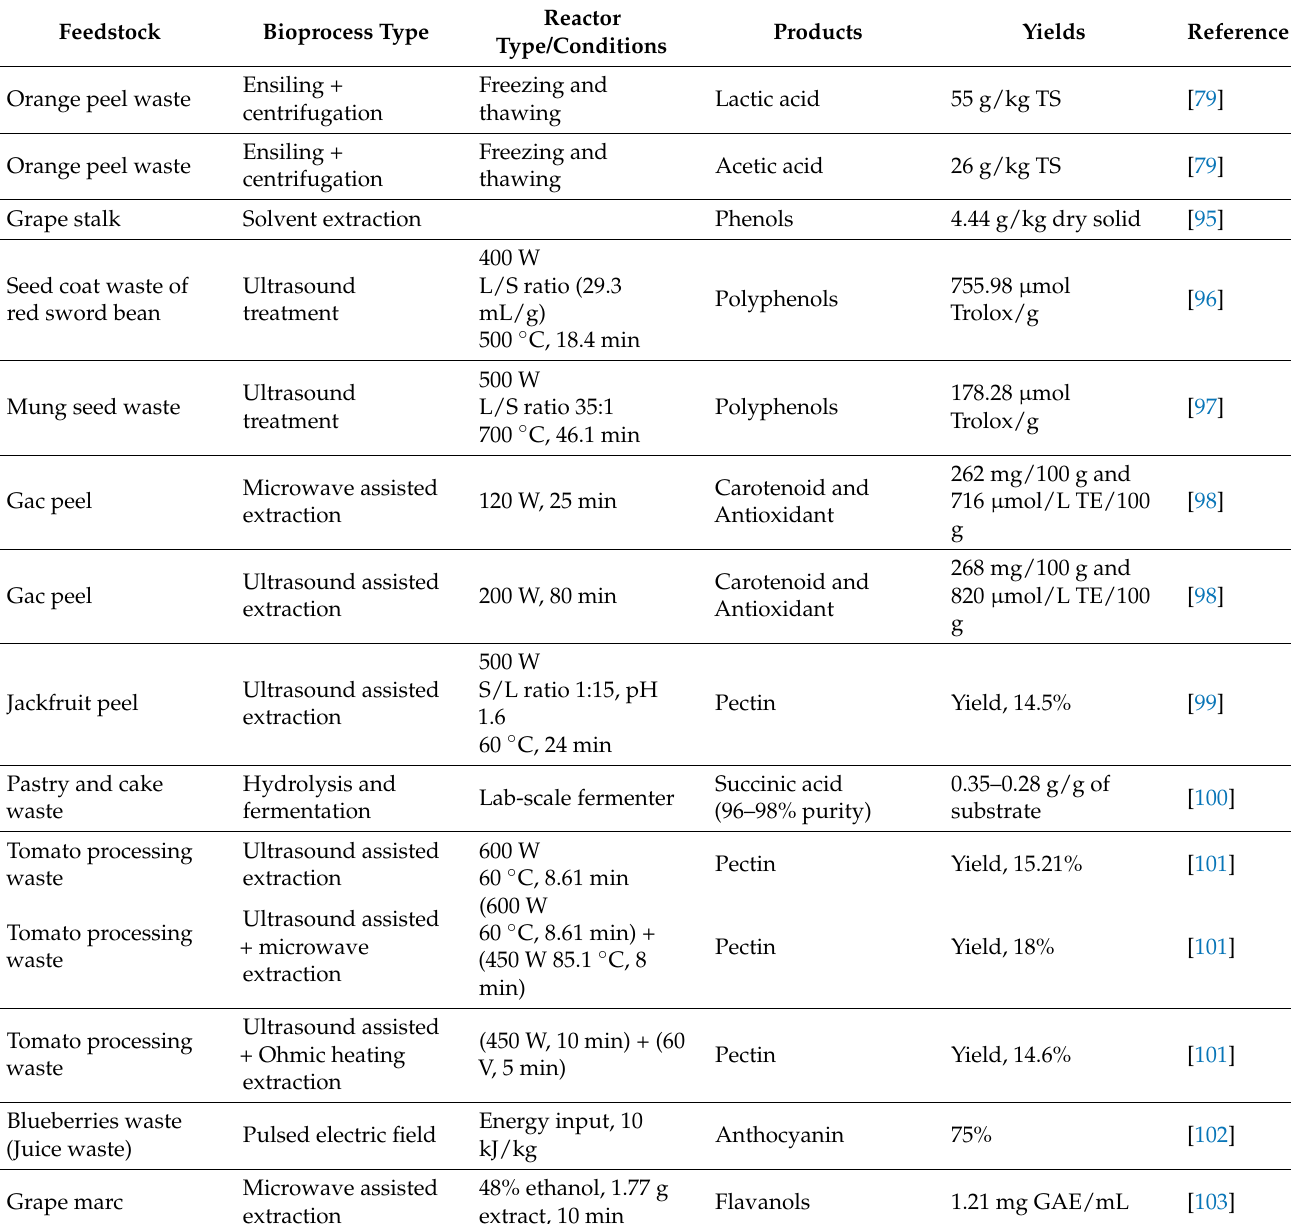
Table 3. Platform chemicals and bioactive compounds produced from food waste